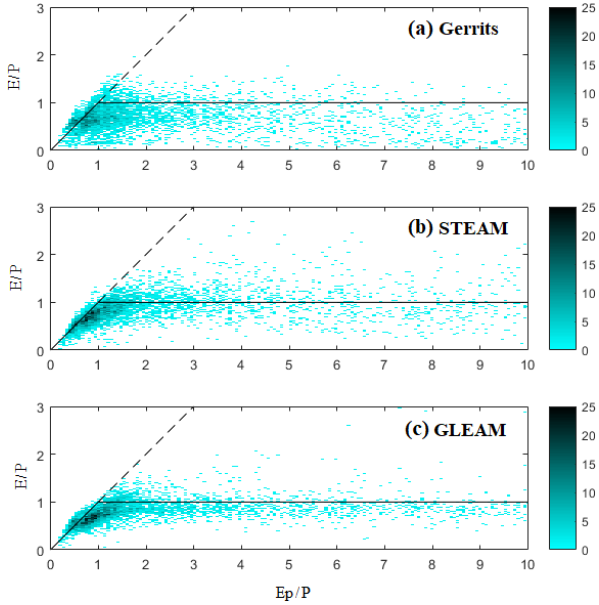
Figure 6. Taylor diagram for mean annual transpiration estimated by Gerrits’ model in comparison to STEAM (blue circles) and GLEAM (red circles) for all data (no. 1), evergreen needleleaf forest (no. 2), evergreen broadleaf forest (no. 3), deciduous needleleaf for- est (no. 4), deciduous broadleaf forest (no. 5), mixed forest (no. 6), shrublands (no. 7), savannas (no. 8), grasslands (no. 9), croplands (no. 10), and croplands and natural vegetation mosaic (no. 11).